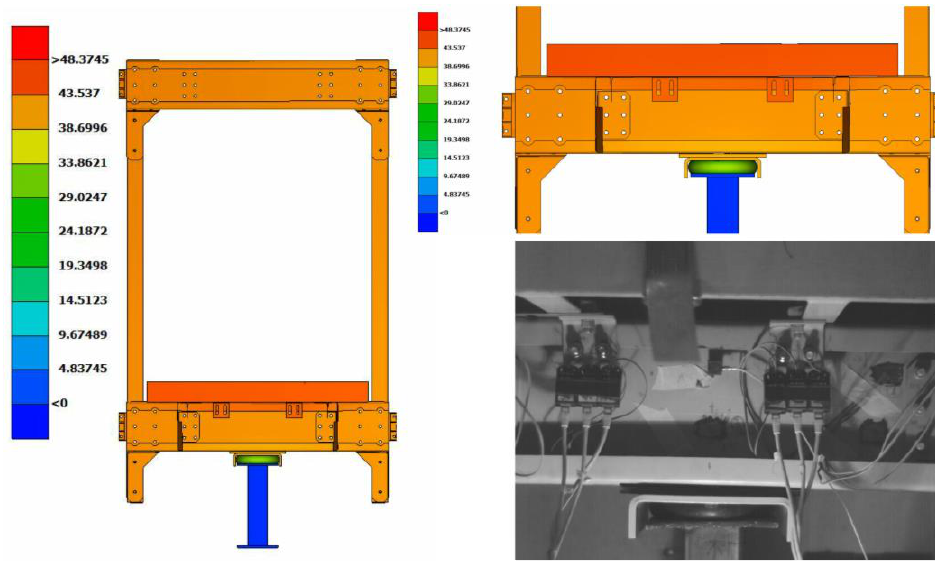
Figure 8. Numerical analysis results and comparison of total deformation (mm) between numerically predicted and experimentally measured maximum displacement.